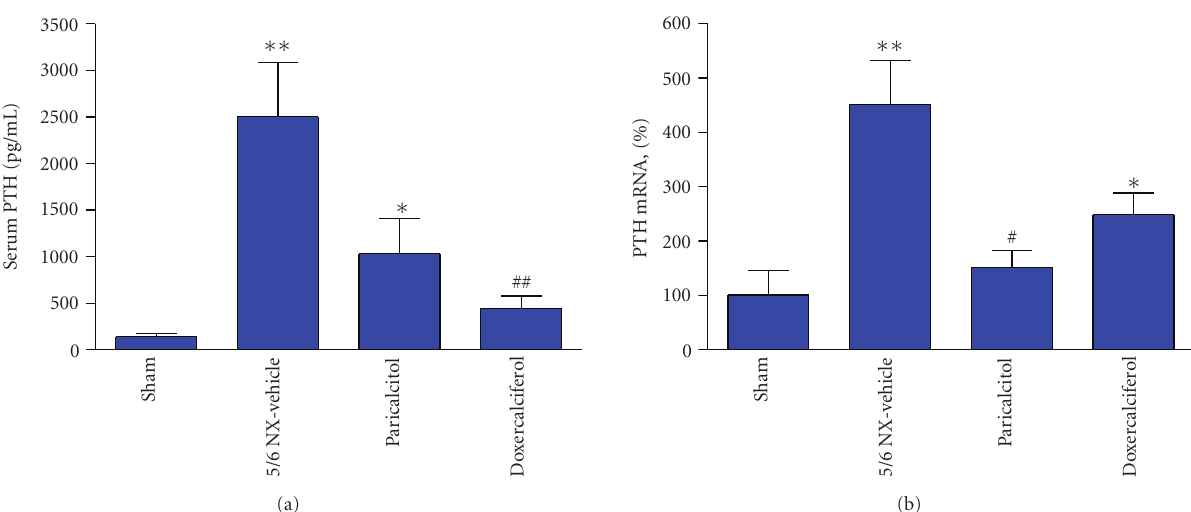
Figure 4: E ff ects of paricalcitol and doxercalciferol on serum PTH and PTH mRNA levels in uremic rats. The 5/6 NX rats on a hyperphosphatemia-inducing diet were treated with vehicle, paricalcitol, or doxercalciferol at 0.33 μ g/kg, i.p., 3 times/week, for two weeks ( n = 8–11 per group). Blood samples and parathyroid gland were collected for the measurement of serum PTH (a) and PTH mRNA (b). For (b), real-time RT-PCR was performed as described in Materials and Methods. The mRNA expression level was first normalized to the GAPDH mRNA level and then calculated as % of control (Sham-vehicle, 100%). One way ANOVA Dunnett test with 95% confidence intervals of di ff erence was performed for statistical comparisons. ∗ P < . 05, ∗∗ P < . 01 versus Sham. # P < . 05, ## P < . 01 versus 5/6